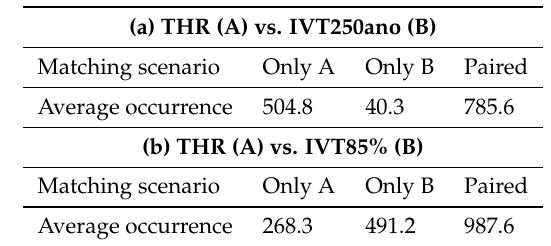
Table 1. ( a ) Matching ARs found by the THR method (labeled as “A” as a shorthand) and the IVT250ano method (labeled “B”). The occurrence numbers per season for the three matching scenarios of (i) onlyA : ARs only detected by method A; (ii) onlyB : ARs only detected by method B. (iii) Paired : ARs detected by both methods; ( b ) similar as in ( a ) but between the THR and the IVT85%